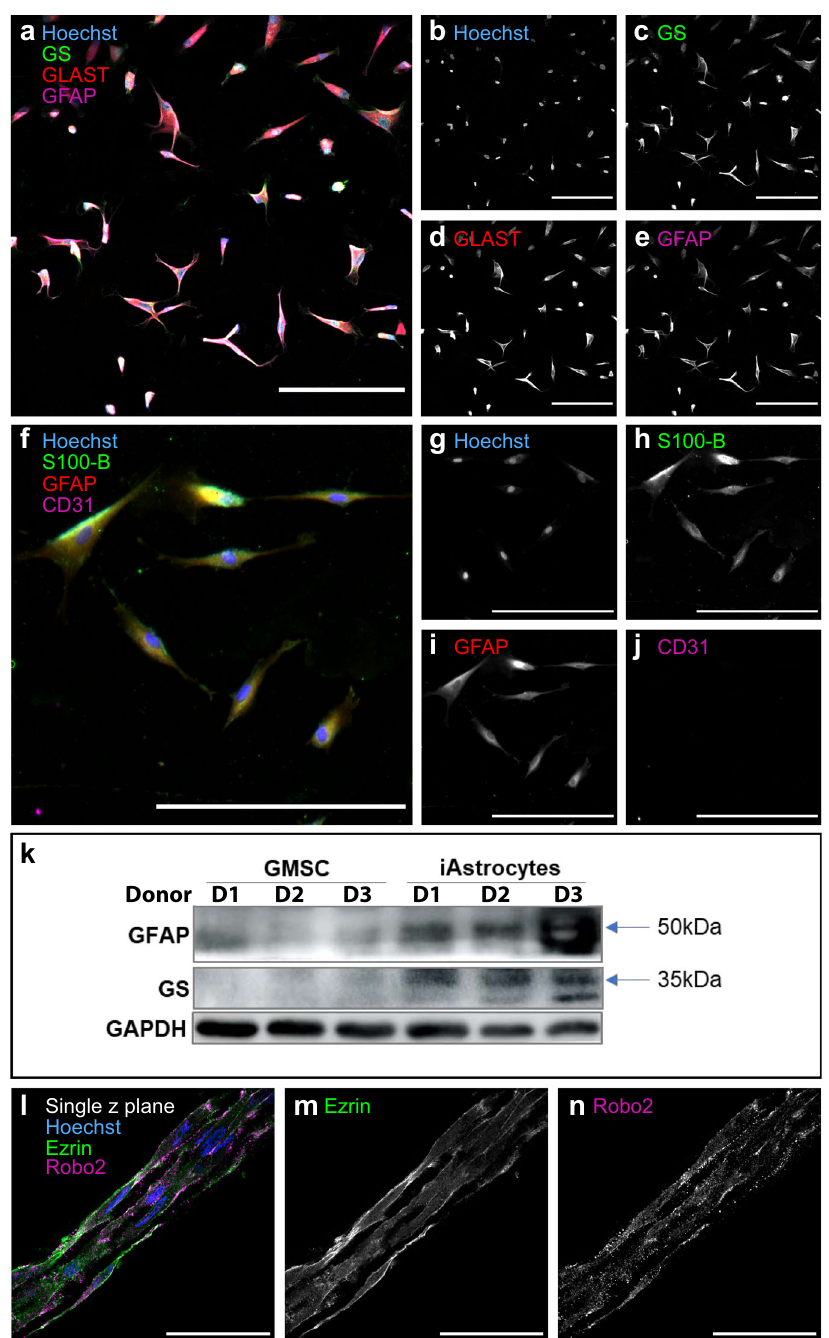
Fig. 4 Astrocyte-like cells can be derived from adult human gingiva mesenchymal stem cells (GMSC) and used for TE-RMS fabrication. A representative image of human GMSC-derived astrocyte-like cells in planar culture is provided with merged fl uorescent channels ( a ), and maximum contrast white-on-black single-channel images are provided for Hoechst staining of nuclei ( b ) and immunostaining that demonstrates expression of astrocytic proteins glutamine synthetase (GS), glutamate/aspartate transporter (GLAST) ( d ), and GFAP ( e ). A merged fl uorescent image is also provided at higher magni fi cation with alternative staining targets ( f ), with maximum contrast white-on-black single-channel images for Hoechst staining of nuclei ( g ) and immunostaining that demonstrates expression of astrocytic proteins S100B ( h ) and GFAP ( i ), but not endothelial marker CD31 ( j ). Western blot analysis from three donors before and after astrocyte induction, demonstrating increased expression of astrocytic proteins GFAP and GS, with GAPDH loading control ( k ). A representative TE-RMS fabricated using the human GMSC-derived astrocytes as starting biomass was labeled with Hoechst nuclear stain, immunostained for Ezrin and Robo2, and imaged via laser confocal microscopy ( l – n ). Single z plane overlay illustrating the bidirectional morphology and longitudinal alignment of astrocytes comprising the human TE-RMS. Maximum contrast white-on-black single z plane images of individual channels at high magni fi cation demonstrate the presence and plasma membrane localization of Ezrin ( m ) and Robo2 ( n ) proteins known to be enriched in glial tube astrocytes. Scale bars: 200 microns ( a – j ), 50 microns ( l – n